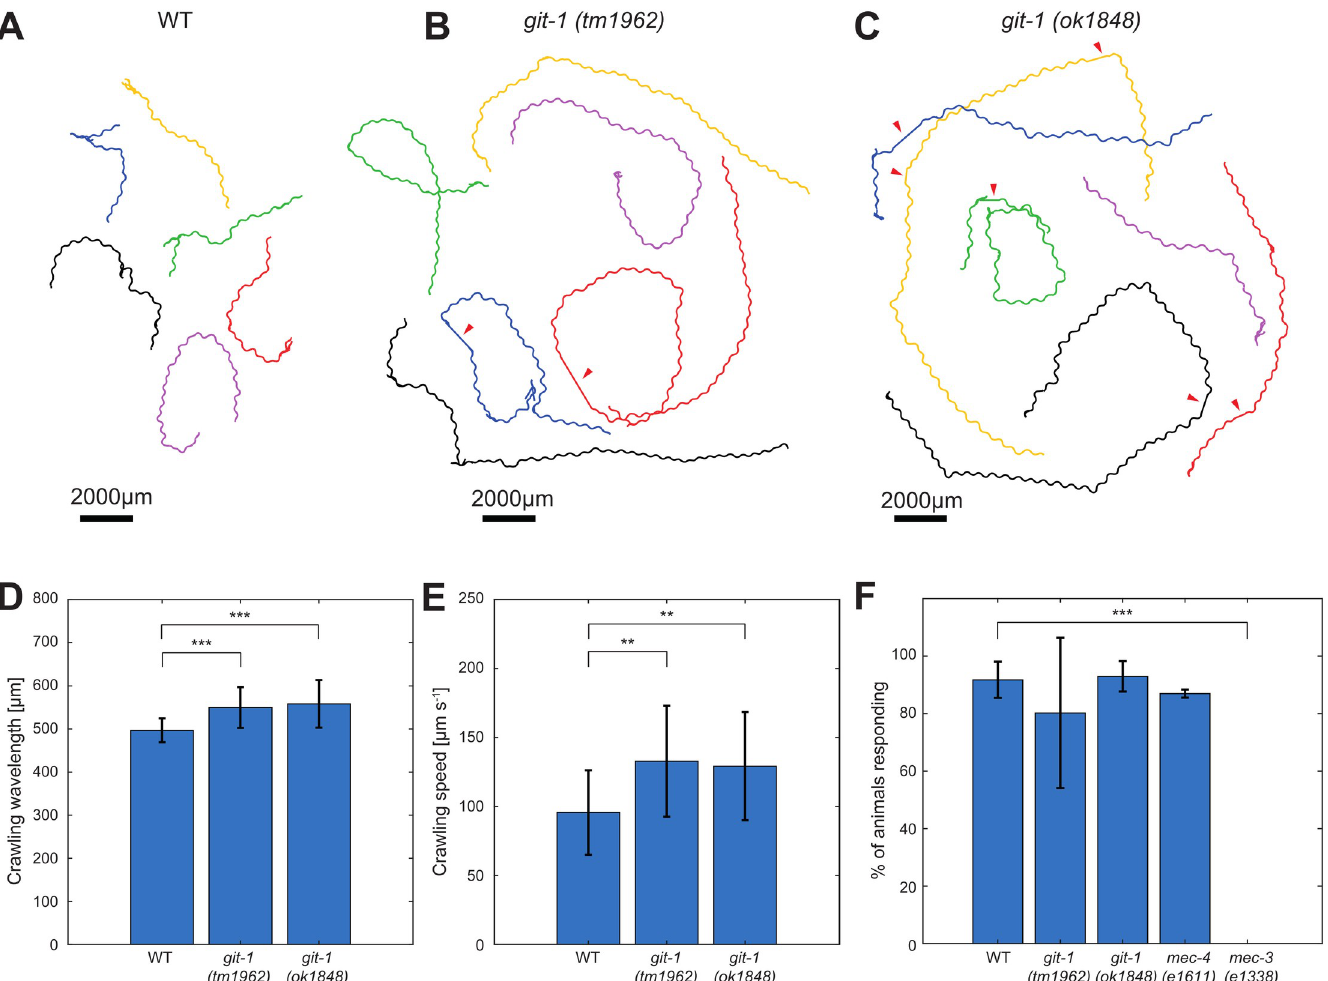
Fig 7. Behavioral characterization of git-1 mutants. A-C. Characteristic tracks obtained by automated video analysis of six animals over three minutes, recorded at 7.5 frames per second (fps), for WT, git-1(tm1962) and git-1(ok1848) animals, respectively. For each genotype, the animals were recorded on a single plate, and the obtained tracks were separated for clarity. Red arrowheads indicate events where the track was lost (see Materials and Methods). D. Crawling wavelength automatically extracted and averaged over a three-minute, 7.5 fps recording. n = 31 WT; n = 15 git-1(tm1962) ; n = 33 git-1(ok1848) . Student’s t test, ��� p < 0.0005. Error bars represent the standard deviation. Values remain significant when normalized per worm length (results not shown). E. Crawling speed normalized by total worm length, automatically extracted and averaged over a three-minute, 7.5 fps recording. n = 31 WT; n = 15 git-1(tm1962) ; n = 33 git1(ok1848) . Student’s t test, �� p < 0.005. Error bars represent the standard deviation. Values remain significant when normalized per worm length (results not shown). F. Percentage of worms executing a harsh-touch-induced escape response. Results are not significant ( p > 0.01) compared to WT for all genotypes except the harsh-touch insensitive mec-3(e1338) . As a negative control, the gentle-touch insensitive mec-4(e1611) animals are used. n = 310 WT; n = 312 git-1(tm1962) ; n = 250 git-1(ok1848) ; n = 150 mec-4(e1611) ; n = 70 mec-3(e1338) , n = 4 independent experiments for WT and git-1(tm1962) mutants, n = 3 independent experiments for git-1(ok1848) mutants and n = 2 independent experiments for mec-4 and mec-3 mutants. Fisher’s exact test, ��� p < 0.0001. Error bars represent the standard deviation.